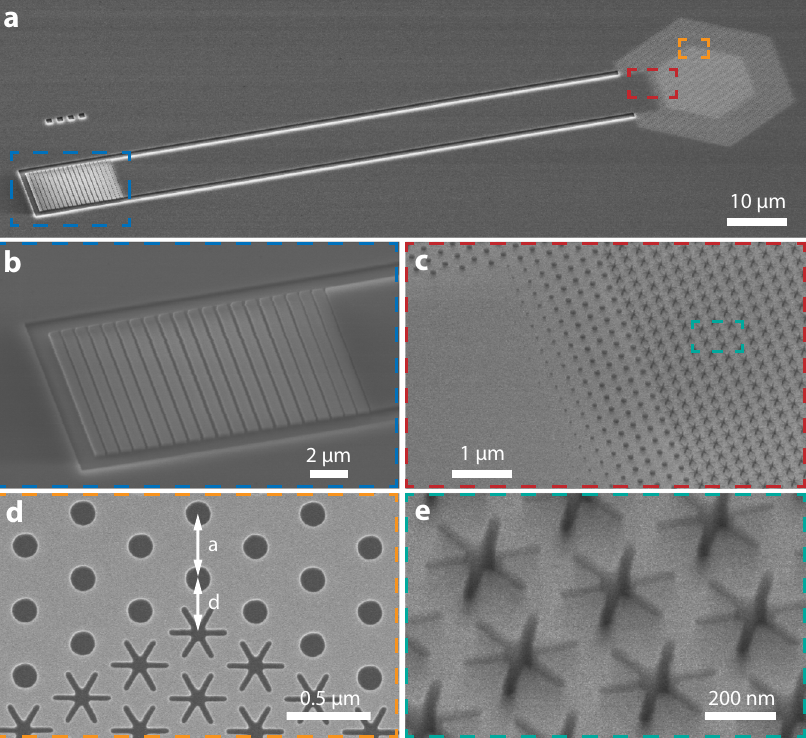
Fig. 2 Scanning electron microscopy of the optomechanical crystal device. a Full device. b Apodized grating coupler. c Junction between the optomechanical crystal and waveguide with tapered photonic crystal mirrors. d Boundary between the optomechanical crystal and photonic crystal mirror. The photonic crystal mirror is displaced by d ‒ a . e Zoom-in view of the optomechanical crystal.